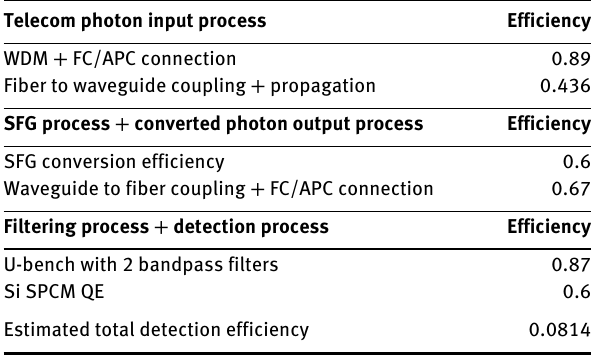
Table 2: Channel efficiencies of the